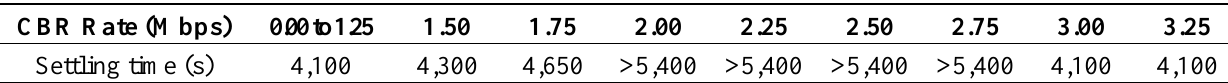
Table 4. Settling time vs . CBR